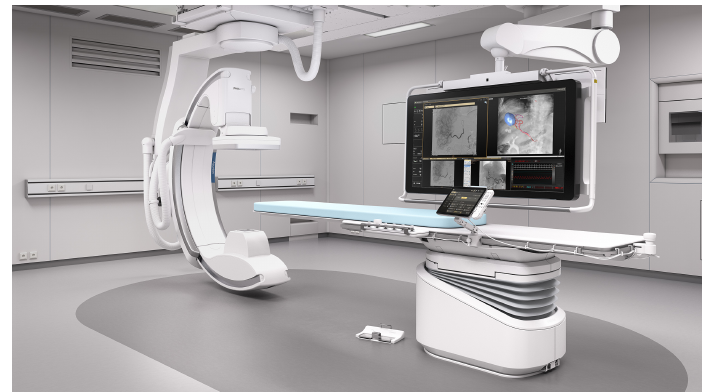
Figure 1. Example of a medical imaging laboratory (Philips CathLab R (cid:13)